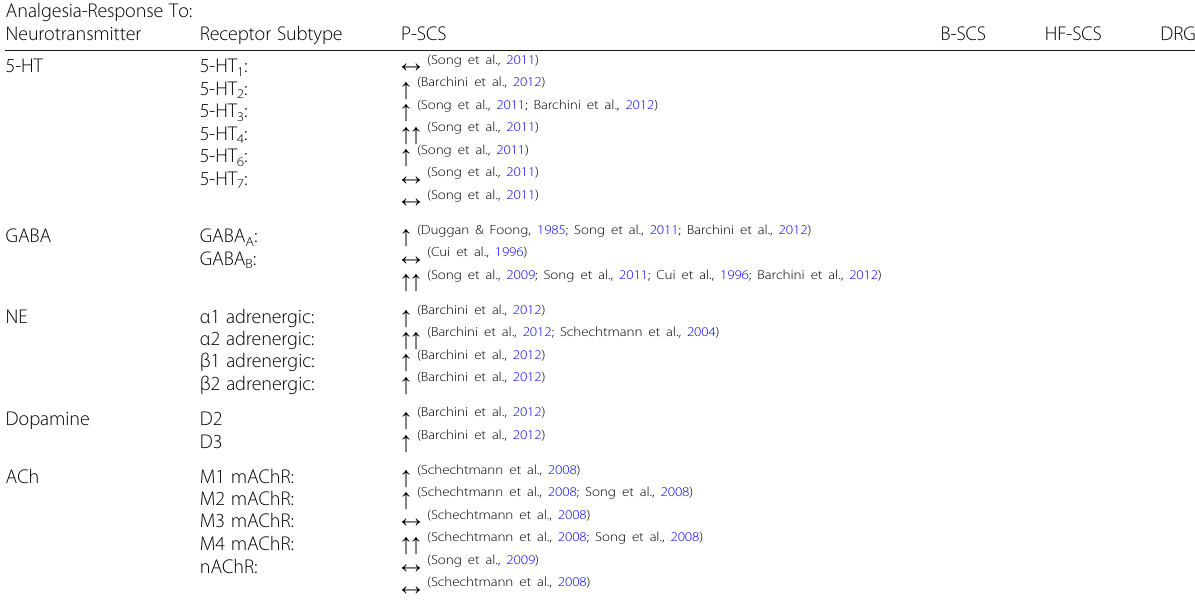
Table 2 Spinal cord stimulation exerts analgesia by activating specific receptor subtypes Analgesia-Response To: Neurotransmitter Receptor